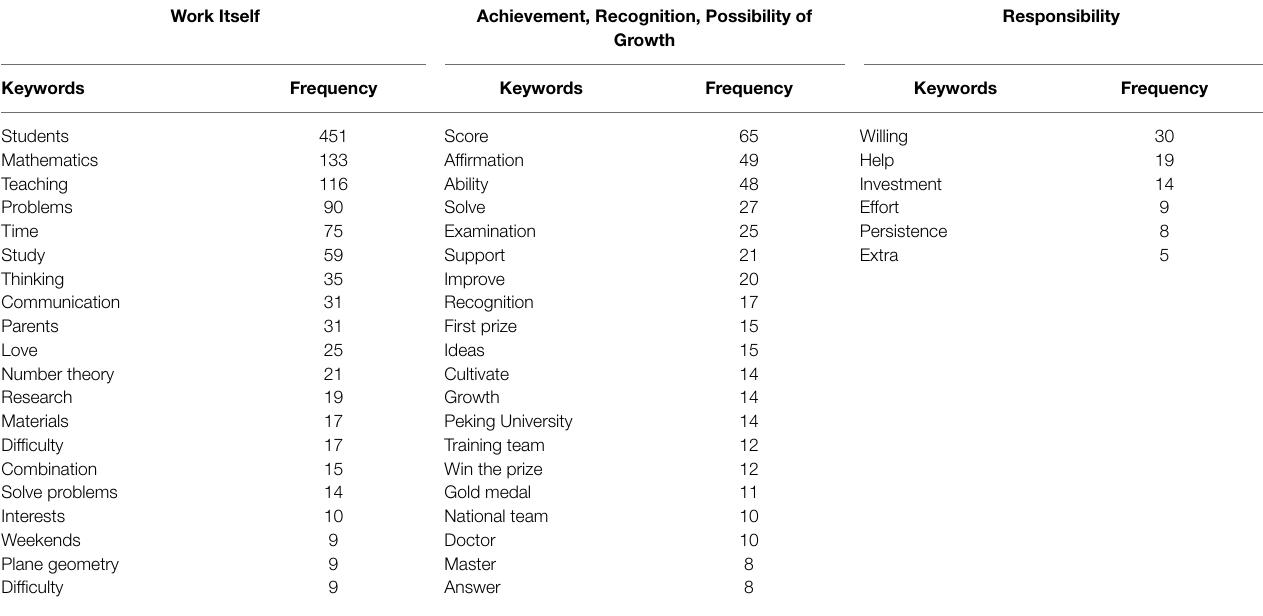
TABLE 4 | Keywords and frequency of each motivation factor. Work Itself Achievement, Recognition, Possibility of